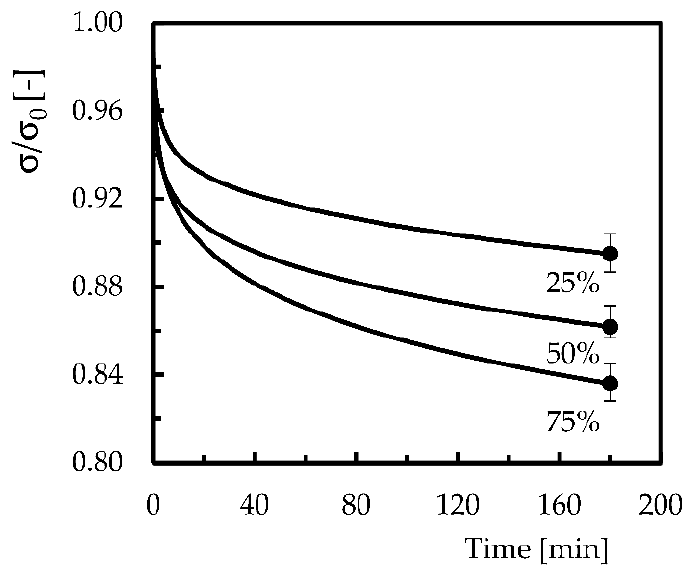
Figure 6. Stress relaxation curves for PETG.